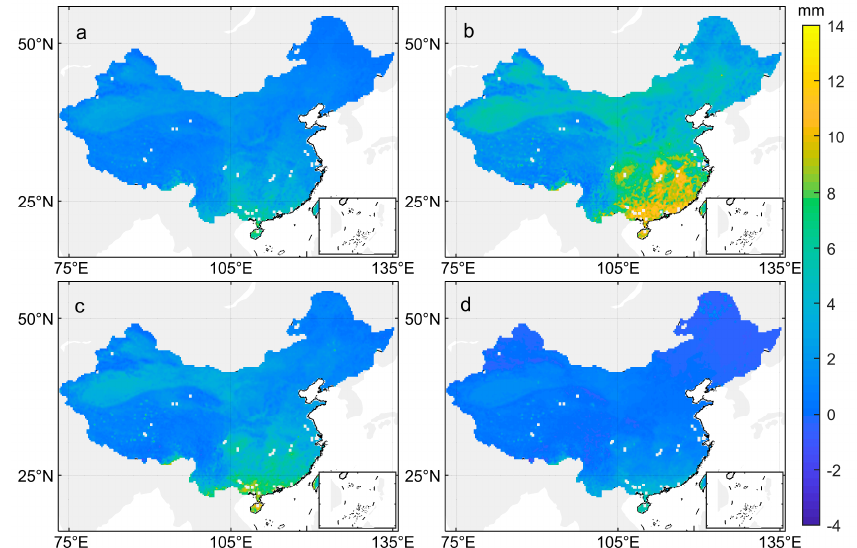
Figure 9. Distribution of seasonal biases between ERA-PWV and MOD-NIR-PWV in the six-year period studied over each grid point in ( a ) spring, ( b ) summer, ( c ) autumn, and ( d ) winter.